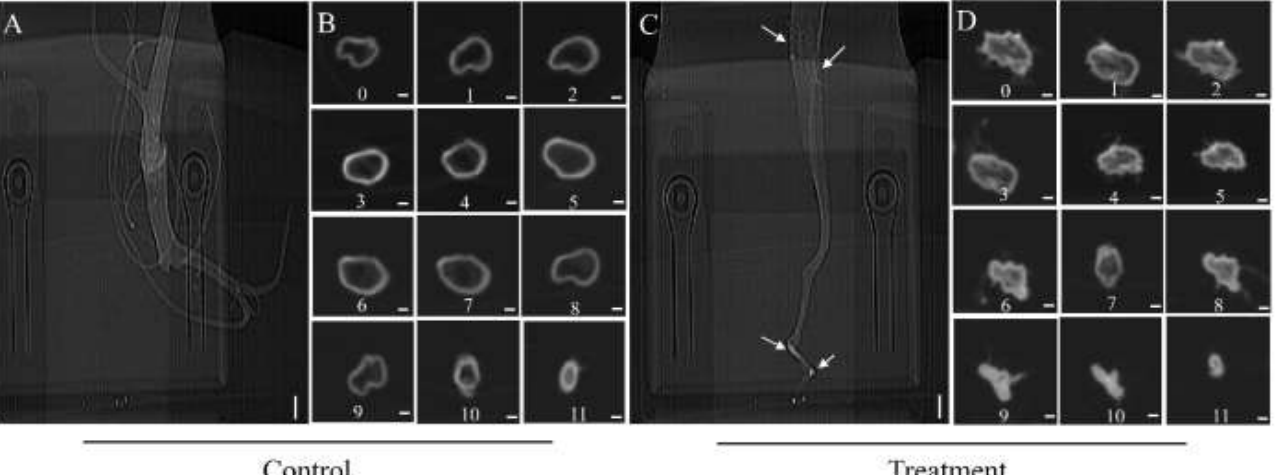
Figure 2. X-ray CT imaging of roots of poplar seedlings in different soil types. ( A ) Sand + ½ MS; ( B ) clay + ½ MS; ( C ) loam + ½ MS; ( D ) vermiculite + ½ MS. The scale is 1 cm. The white arrow represents the location of the X-ray CT imaging density.